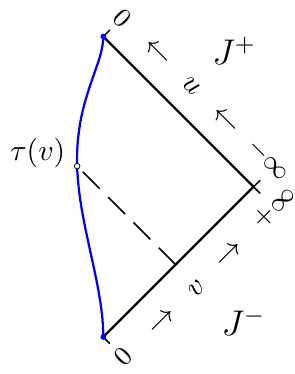
Figure 3 . Penrose diagram showing the ranges of u , v and de(cid:12)nition of (cid:28) ( v